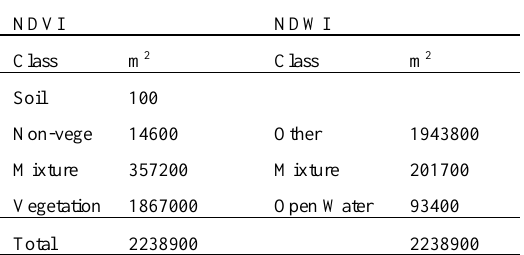
Figure 8. Accuracy assessment; comparison to the results with high-resolution image.